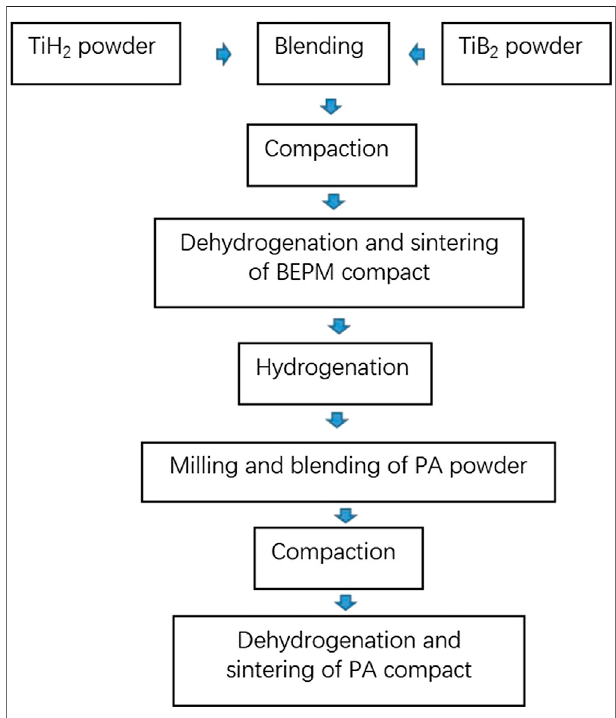
FIGURE 8 | Scheme of the two-stage BEPM + PA press-and-sinter manufacturing process used to make Ti/TiB composites.